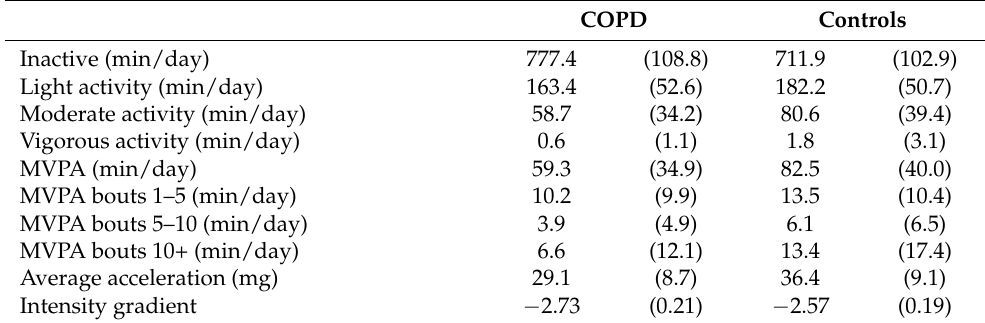
Table 2. Accelerometry summary data, reported as mean (SD) unless otherwise stated.